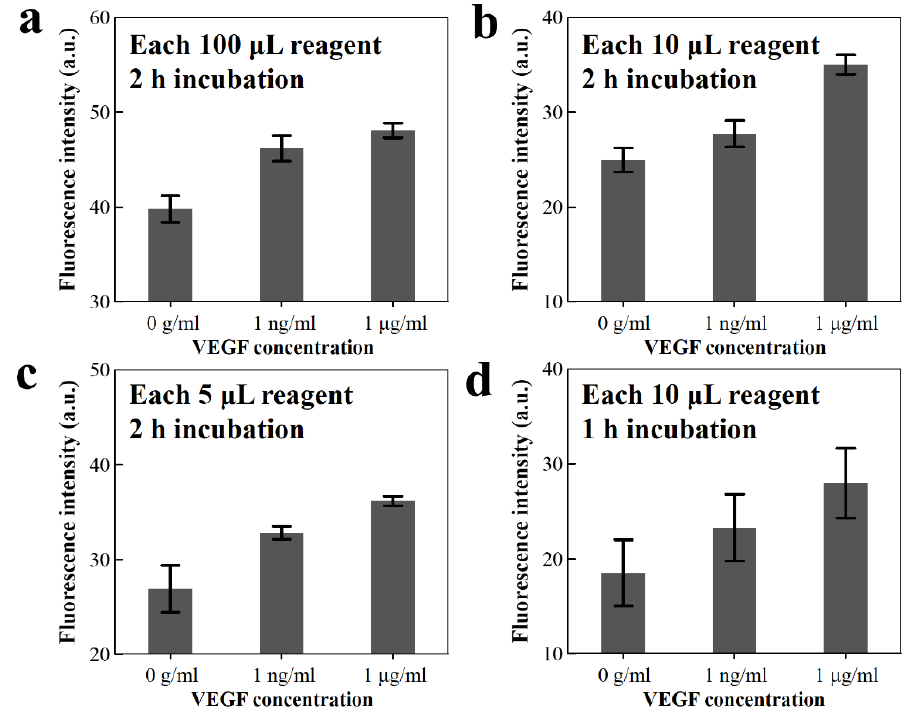
Figure 4. ( a – c ) Green fluorescence intensity of the fluorescent dye-coupled VEGF on the microbeads after 2 h incubation, with reagent volumes of 100, 10, and 5 μ L, respectively, and ( d ) 10 μ L reagent volume for 1 h incubation.